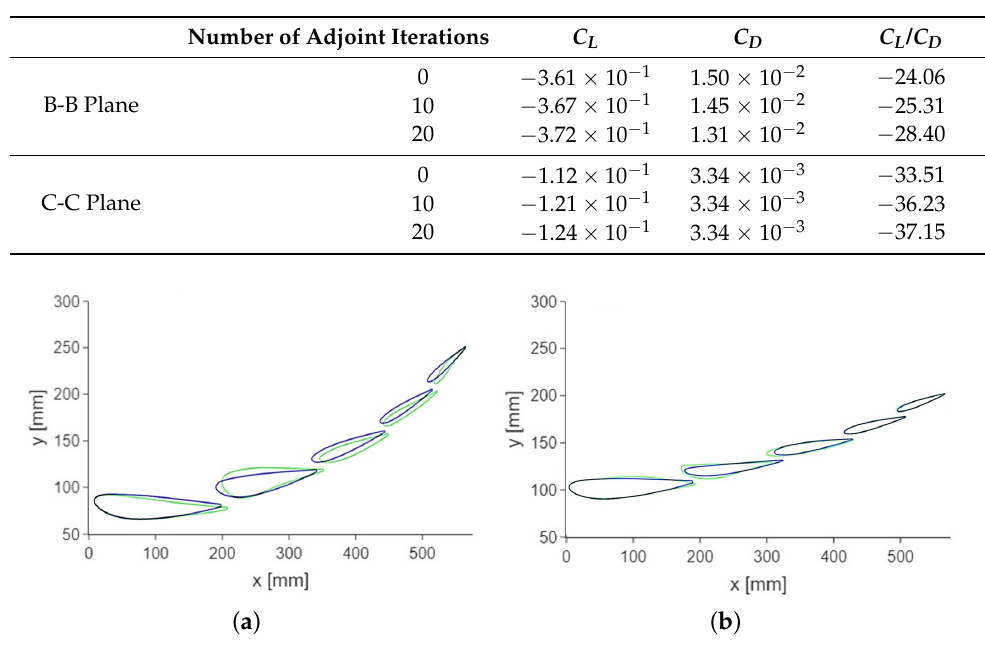
Figure 9. Visual differences between parametric (color blue) and hybrid optimal designs (color green). ( a ) Plane B-B, and ( b ) Plane